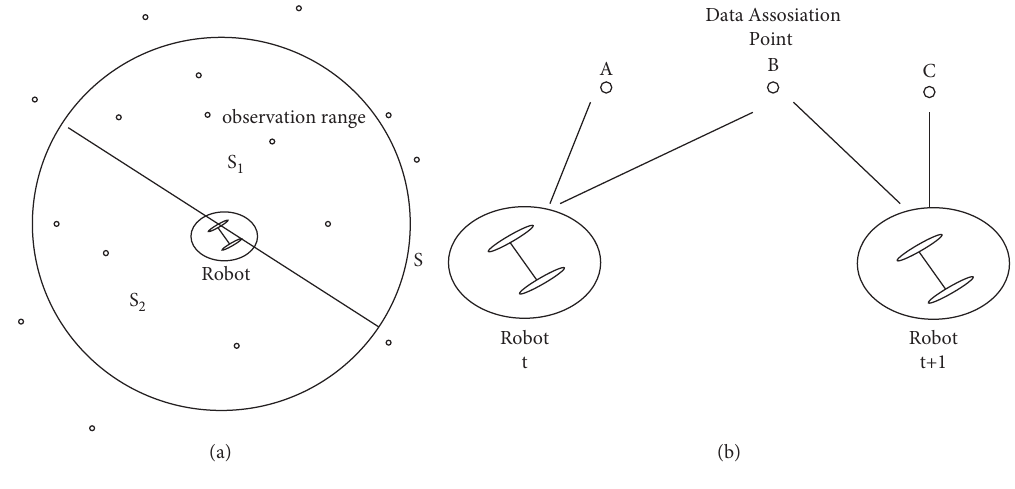
Figure 2: (a) Observation range; (b) local data association.